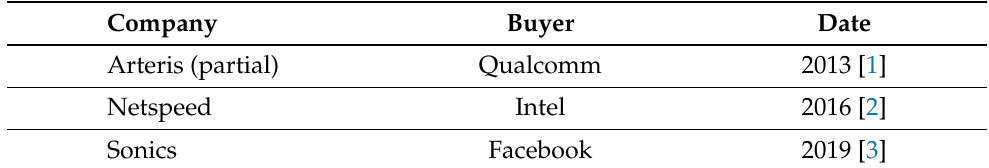
Table 1. Large Silicon Valley companies bought NoCs companies. Qualcomm made a partial purchase on Arteris, which preserves its patents.